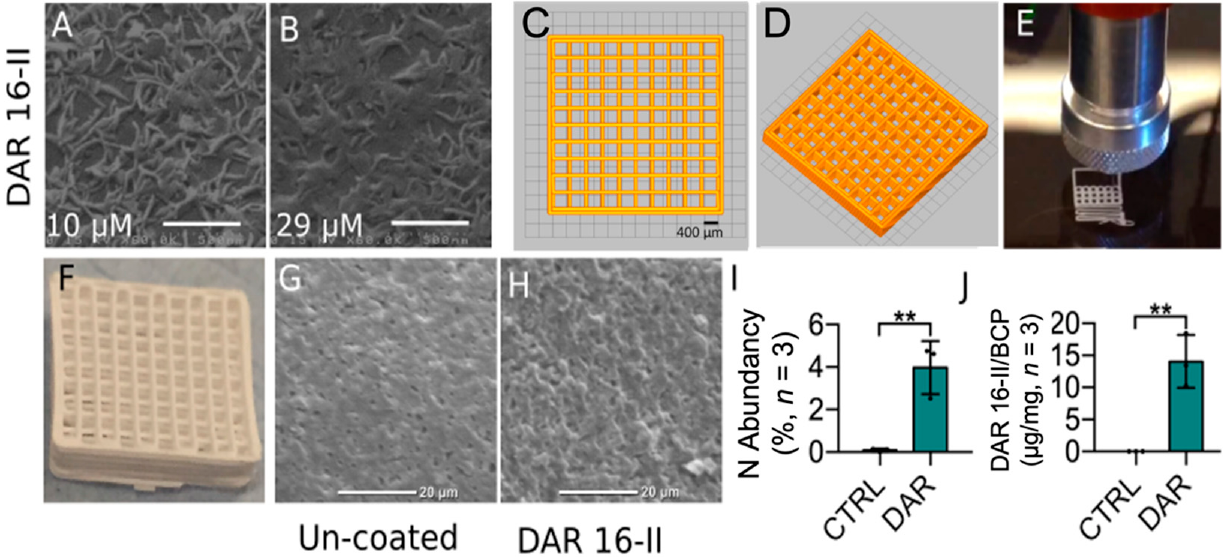
Figure 4. The preparation and characterization of 3D-printed BCP scaffolds enriched with DAR 16-II. ( A , B ) SEM imaging of DAR-16-II-coated glass slides: DAR 16-II formed nano-structures with major axes in the 250–500 nm range, and presenting finer irregularities in the 50–100 nm range; ( C , D ) BCP 3D-printed scaffolds with 400 µm pores; ( E , F ) 3D direct printing of BCP at 200 µm resolution and the final scaffold after sintering; ( G , H ) SEM images of un-coated or DAR-16-II-coated BCP; ( I ) elemental analysis of BCP-coated and un-coated samples (three randomly picked spots per sample) demonstrated the presence of nitrogen on the BCP surface related to the peptide coating; ( J ) quan- tification of DAR 16-II adsorption on the BCP scaffolds through a micro-BCA assay. ** p < 0.01